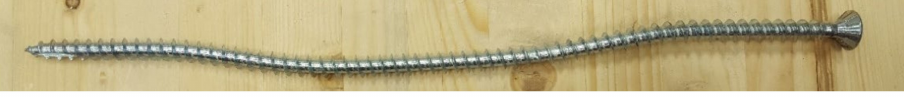
Figure 29. Deformed fastener after experimental